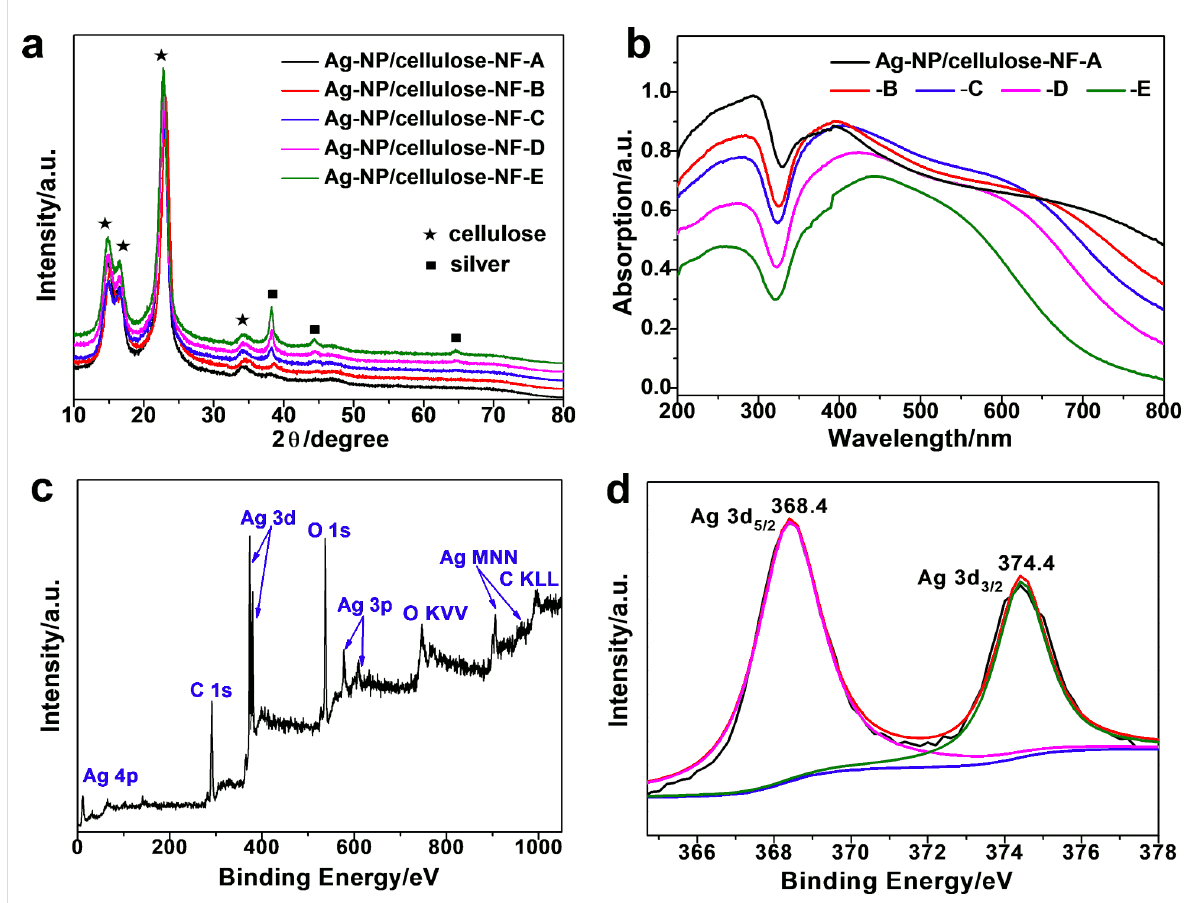
Figure 3: X-ray diffraction patterns (a) and diffuse reflectance UV–vis spectra (b) of Ag-NP/cellulose-NF–A, B, C, D, and E. X-ray photoelectron spec- troscopy (XPS) survey spectrum (c) and high-resolution XPS spectrum of the Ag 3d region (d) of sample Ag-NP/cellulose-NF–C.